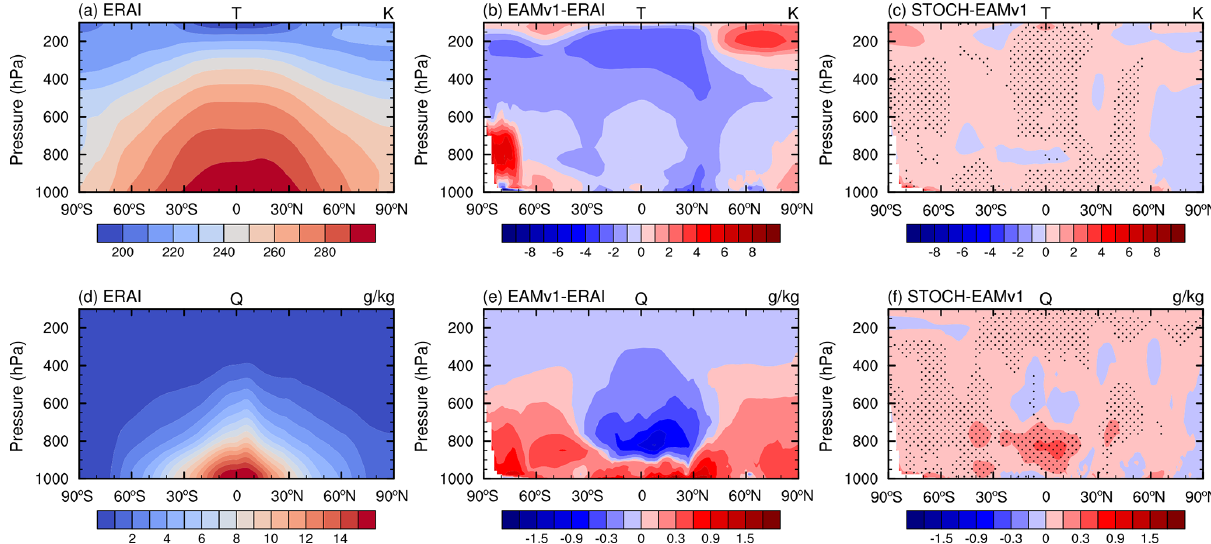
Figure 12. Annual and zonal mean cross sections of (a–c) temperature and (d–f) specific humidity for (a, d) ERAI and differences for (b, e) EAMv1-ERAI and (c, f) STOCH-EAMv1. Differences with a confidence level greater than 95% between STOCH and EAMv1 are